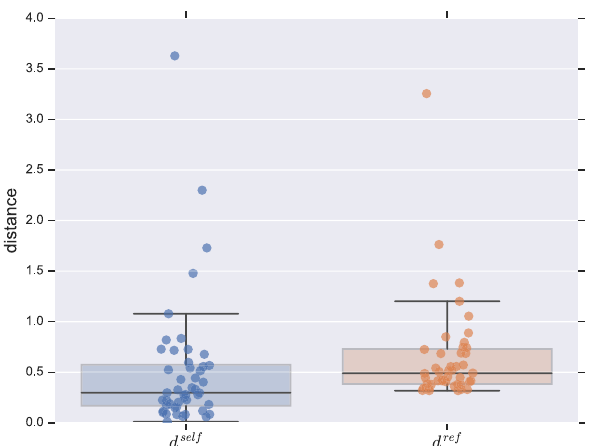
Figure 3. Evidence of the persistence of η through time windows. The boxplot to the left (blue) shows the distribution of distances between the parameter estimates for the same individual at consecutive time intervals ( d self ). The boxplot to the right (orange) shows the distribution of reference distances between the parameter estimate for each individual and the rest of the population ( d ref ). In both cases, the solid dots represent the empirical points— jittered for a better visualisation. The distances in d ref are consistently higher than those in d self , meaning that the individual’s η tends to be persistent across time intervals (see “Mobile phones dataset” section for